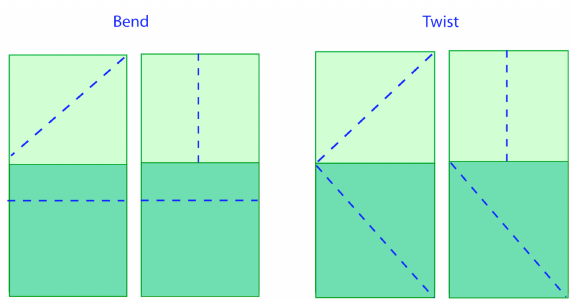
Figure 4. Abstracted model of the relationship observed between cellulose orientation and shape change in hygronastic seed pods source: Kapsali